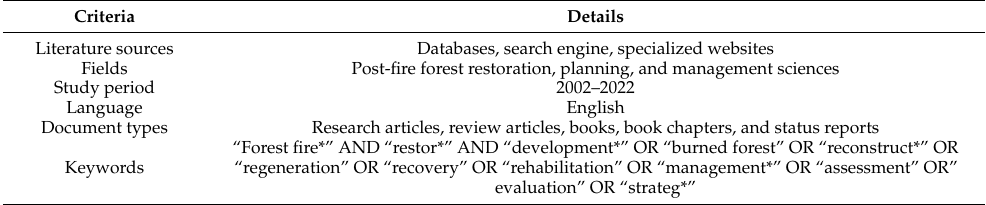
Table 1. Summary of the criteria used in the systematic literature